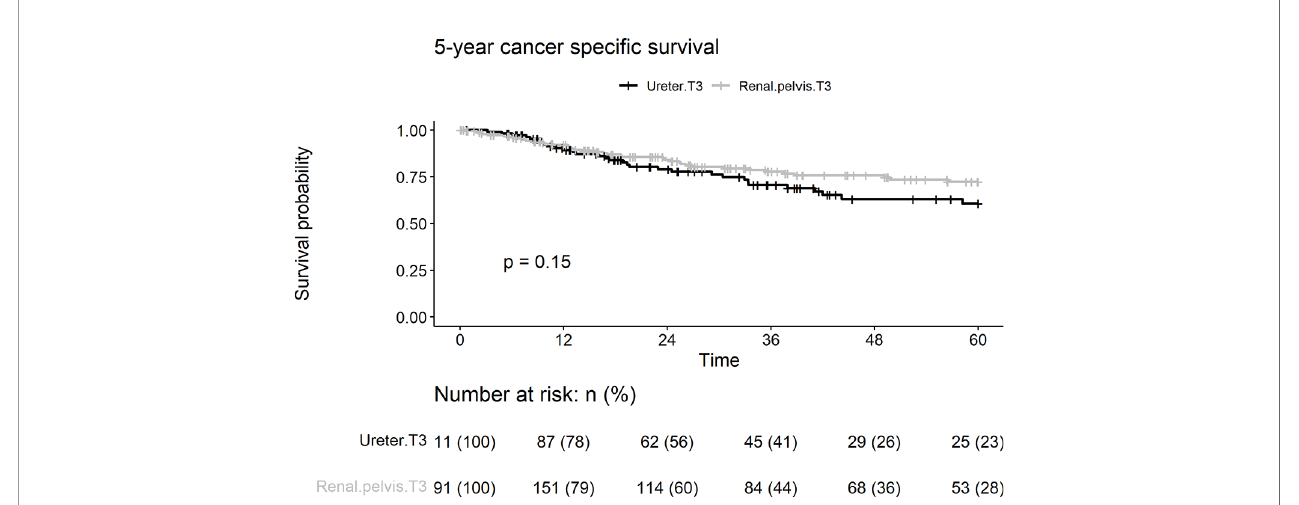
FIGURE 4 | Kaplan-Meier analyses for 5-year cancer speci fi c survival strati fi ed by tumor stage among patients with pT3N0M0 upper tract urothelial carcinoma following radical